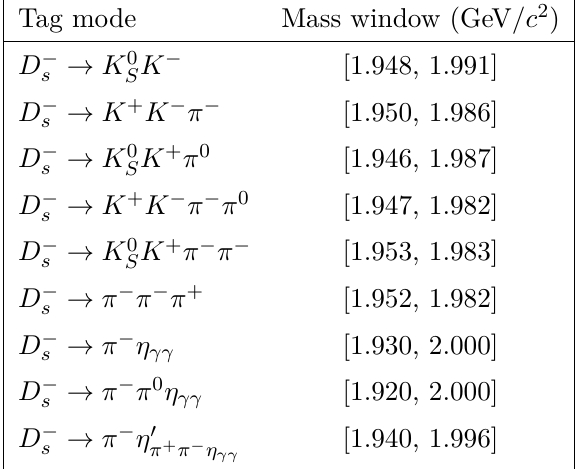
Table 3 . Requirements on M tag for various tag modes, where the η and η 0 subscripts denote the decay modes used to reconstruct these